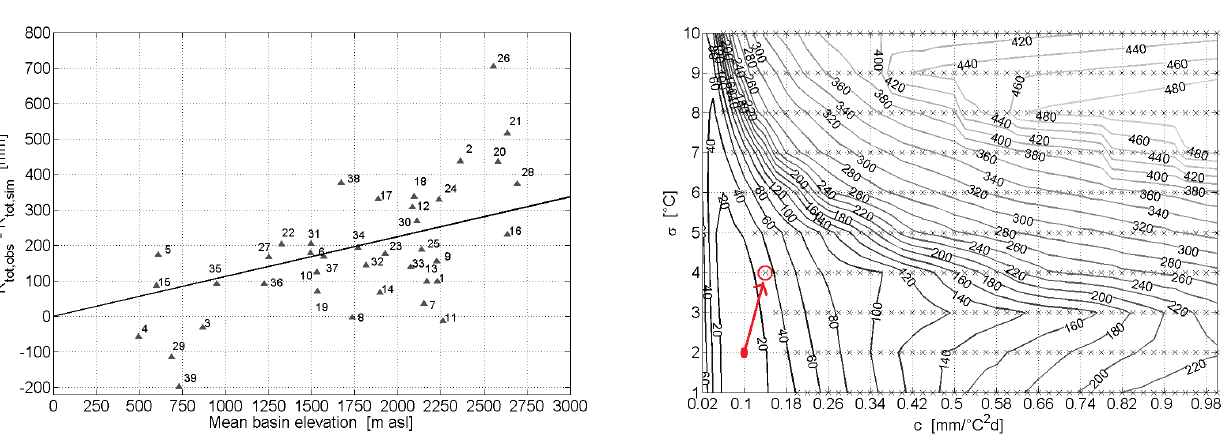
Fig. 3. Linear regression between mean basin elevation h and model Fig. 4. MAE sensitivity to the values of c and σ for river Evanc¸on bias b = R tot , obs − R tot , sim for the reference run. Dark triangles at Champoluc (local scale application of the water balance model). represent the model bias for each basin. The numbers refer to the Crosses represent the parameter combinations that fulfill the condi- basin-ID, as reported in the table in the supplementary material. tion over the depletion of the snow The regression is significant with a level α = 0 . 01 and a coefficient = 0 . 676. of determination R 2 adj